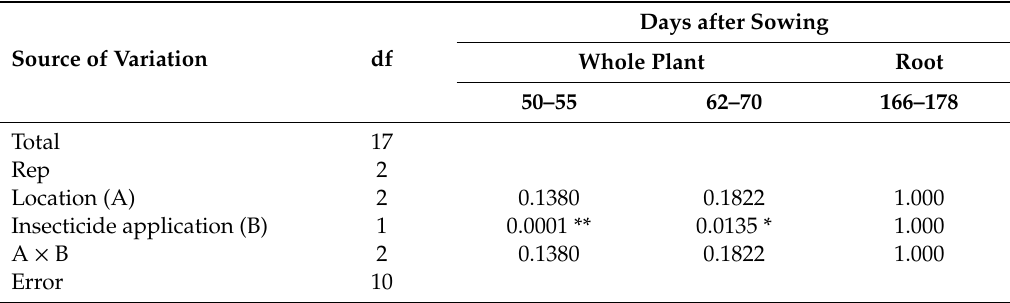
Table 6. Imidacloprid residues in the whole plants during the first two observing periods and for roots at harvesting in 2016.